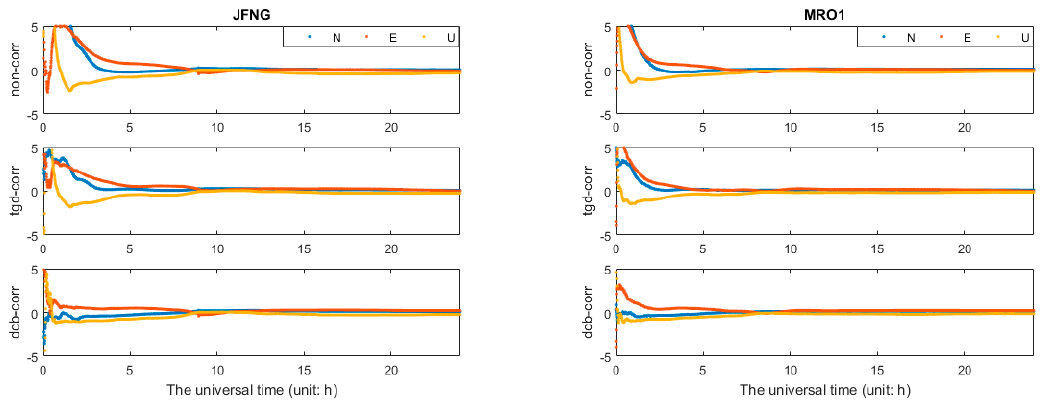
Figure 8. Positioning results (N, E, and U) of b1b3 GPS/BDS/Galileo PPP (unit: m).